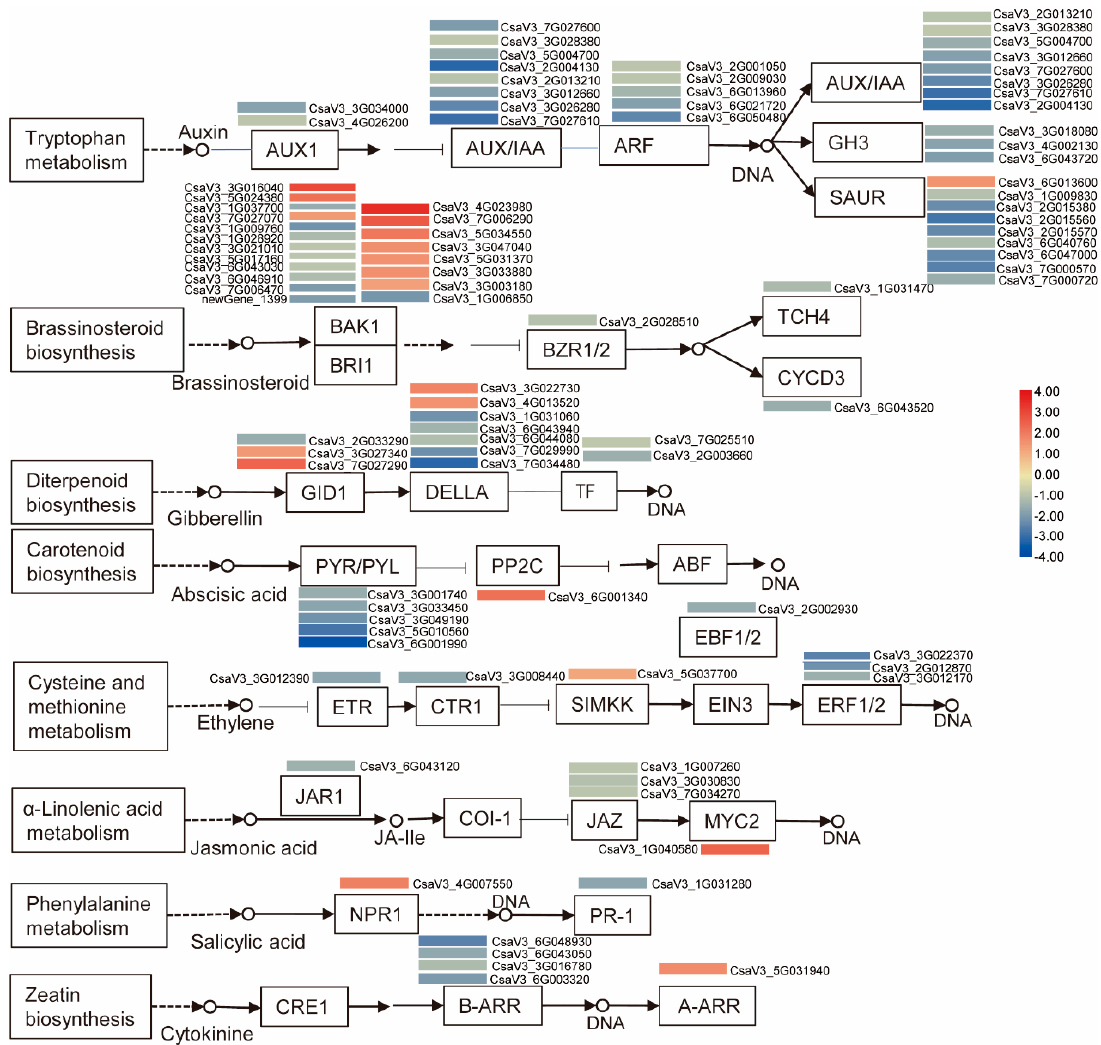
Figure 8. Processes of plant hormone signal transduction were significantly different between CT57S and CT90R in leaves. The process map was modified based on map ko04075.